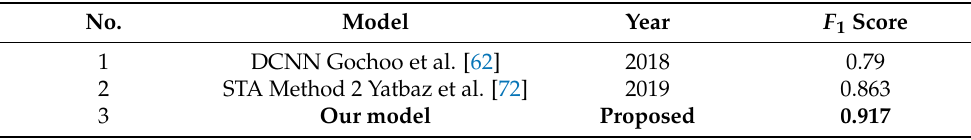
Table 9. Comparing Present Model with Existing Models.